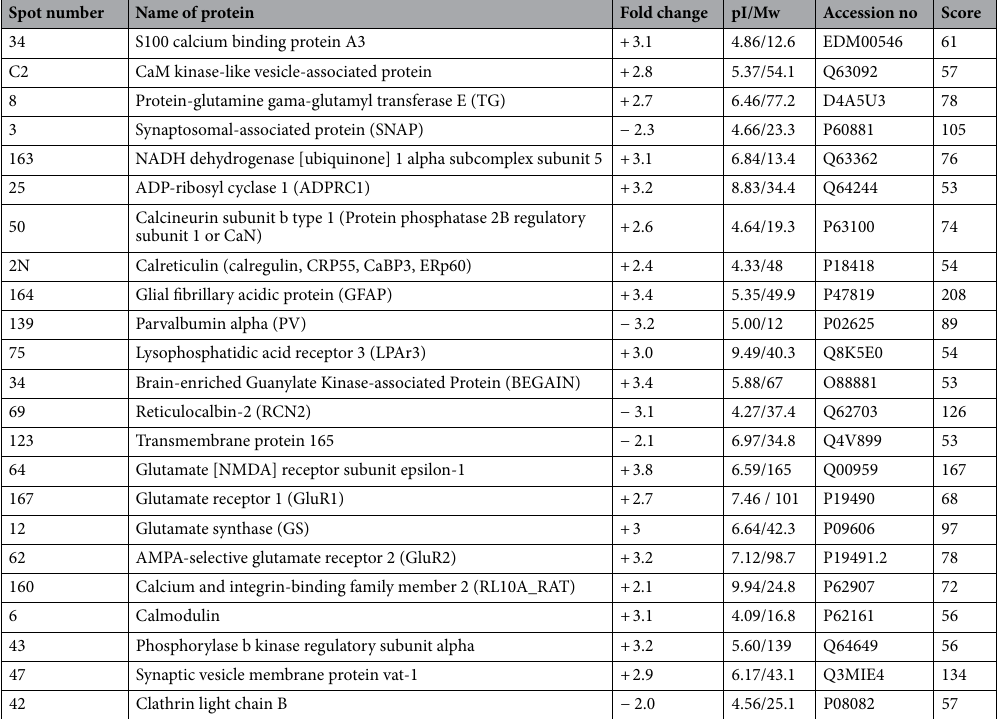
Table 1. The list of proteins differently expressed in three models of epilepsy in comparison with control that involved in calcium homeostasis